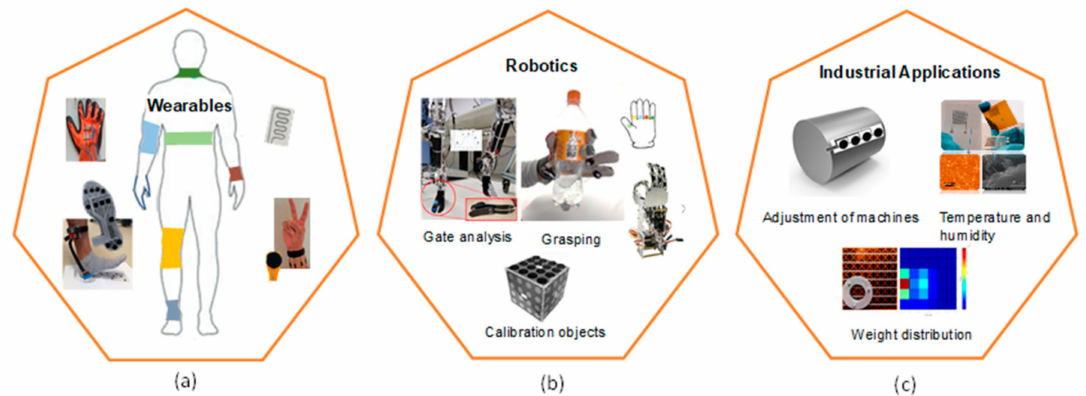
Figure 1. Examples of applications of strain and pressure sensor based stretchable and flexible nanocomposites: ( a ) wearables for human activity tracking and medical applications, ( b ) robotics application for grasping, humanoid robot gait analysis and calibration objects and ( c ) industrial applications.